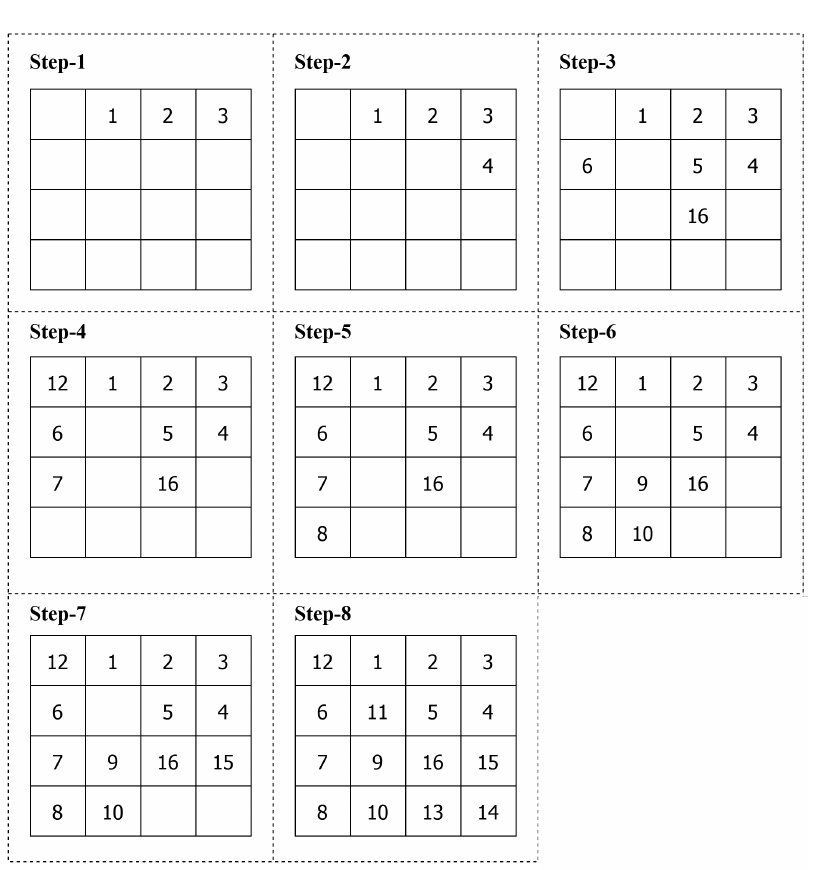
Figure 4. Initial mapping of VOPD task graph on 4 × 4